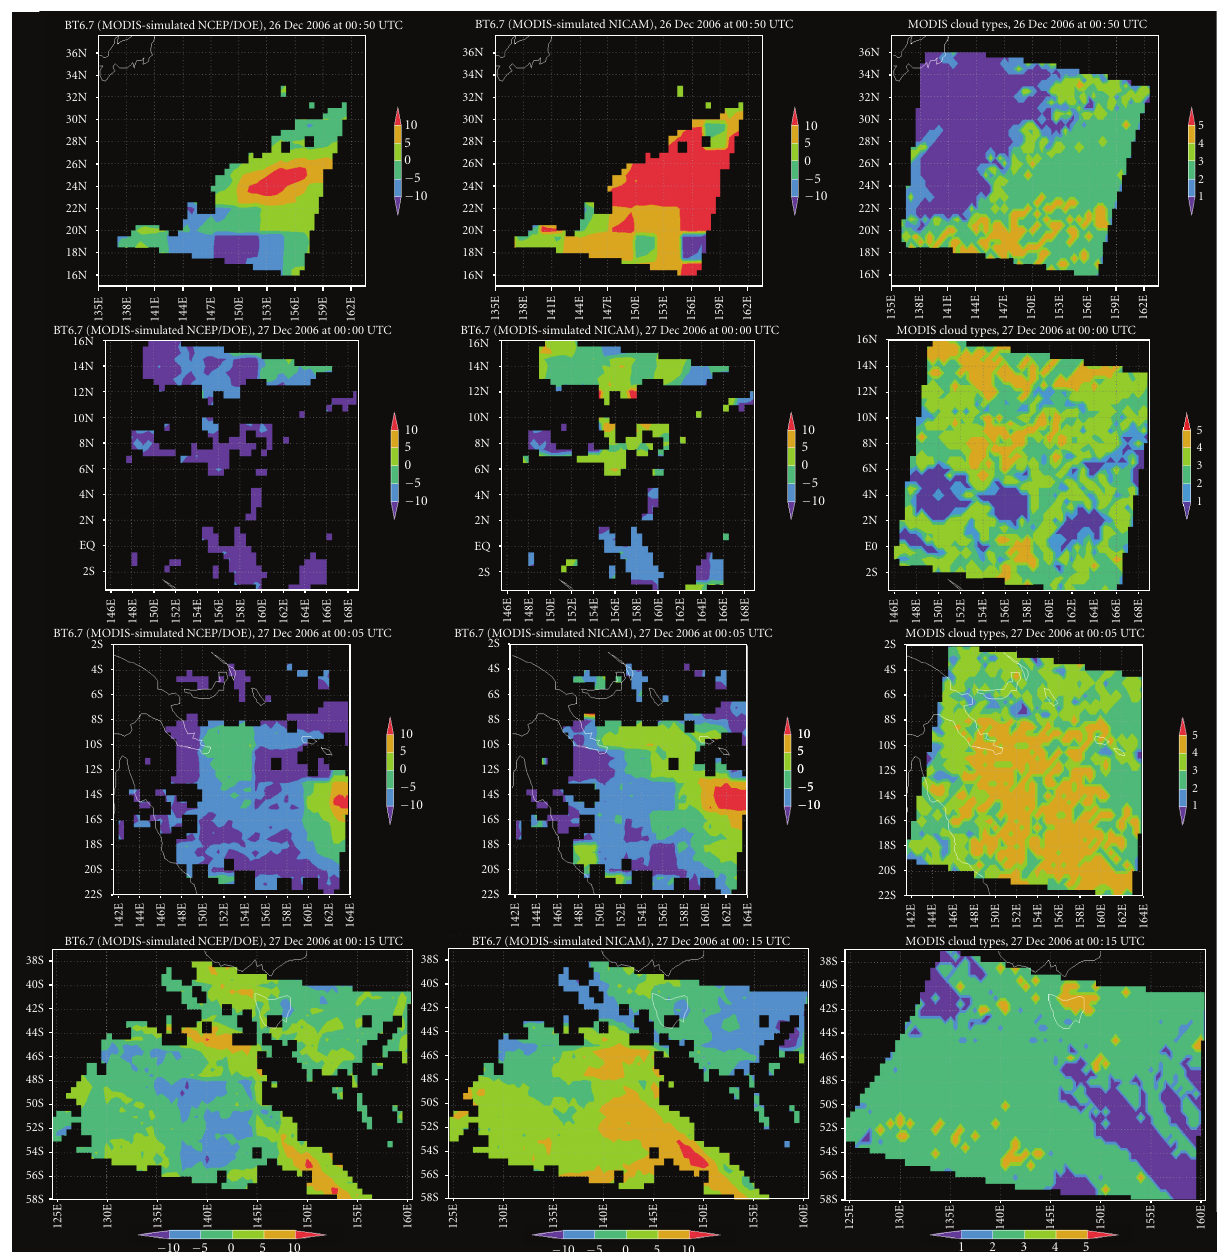
Figure 4: Di ff erences between MODIS observed and NCEP/DOE simulated BT6.7 in K (1st column) then NICAM (2nd column), and the cloud types (3rd column) corresponding (1 = convective clouds, 2 = middle clouds, 3 = low clouds, 4 = thin cirrus clouds and 5 = clear